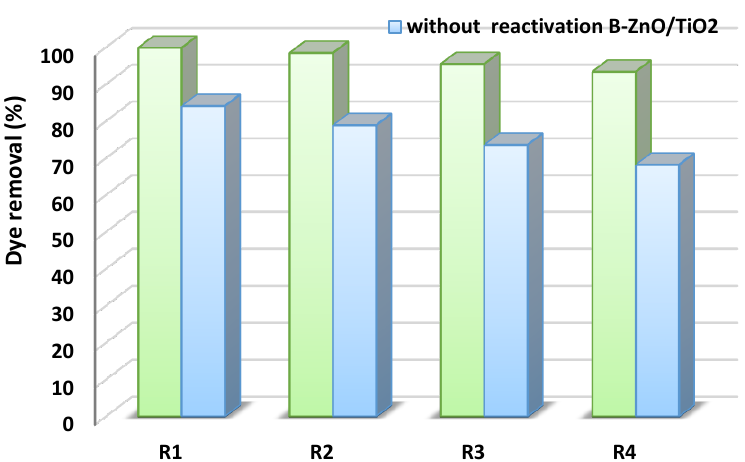
Figure 15. Cycling runs of B-ZnO/TiO 2 for the photodegradation of DR16 with and without reactivation.